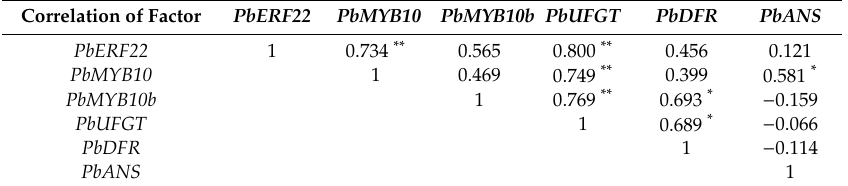
Table 1. Correlation analysis between PbERF22 and anthocyanin biosynthesis-related genes. Correlation of